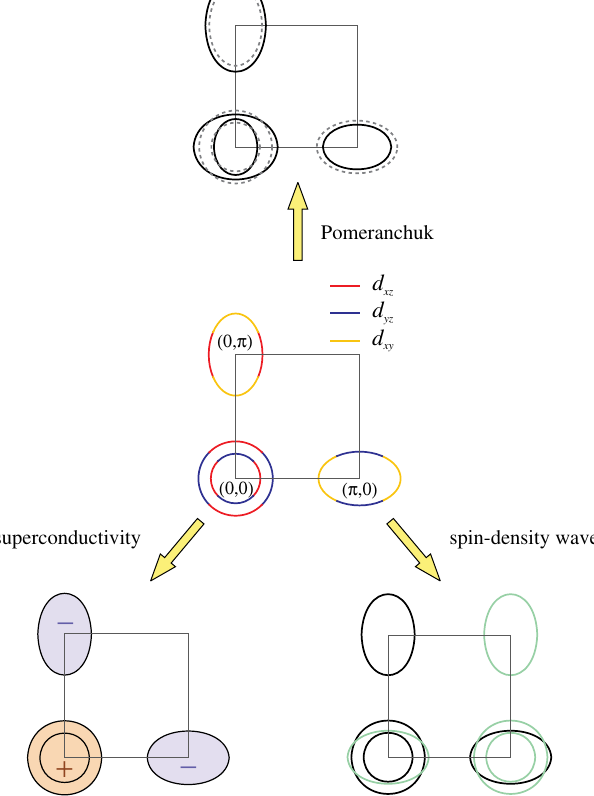
FIG. 1. Low-energy states and potential instabilities. The orbital content of the 2D Fermi surface of the Fe-based super- conductors is plotted together with the changes in the fermionic excitations promoted by one of three electronic instabilities — s þ − superconductivity, stripe SDW magnetism, and nematicity (breaking of C 4 lattice rotational symmetry), which necessarily gives rise to orbital order. The low-energy excitations live near ¼ k ¼ 0 ), and near hole pockets centered at the Γ point ( k x y electron pockets centered at ð 0 ; π Þ ð π ; 0 Þ in the 1-Fe Brillouin zone. Excitations near the hole pockets are made out of d and xz d orbitals, while the ones near the ð 0 ; π Þ [ ð π ; 0 Þ ] electron yz and d ( d and d ) orbitals [3,4]. In pockets are made out of d xz xy yz xy some systems, there exists a third hole pocket (not shown) centered at ð π ; π Þ and made out of the d orbital. s þ − super- xy conductivity gaps out low-energy excitations, and the super- conducting order parameter changes sign between hole and electron pockets. Stripe SDW magnetism with momentum ð 0 ; π Þ or ð π ; 0 Þ (shown) mixes hole and electron states by